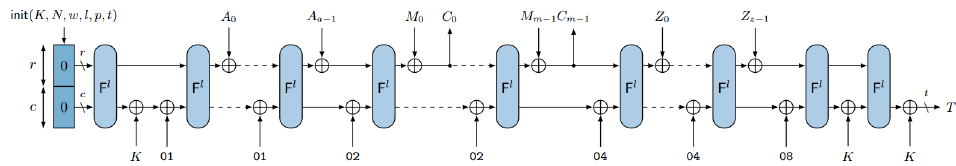
Figure 1: The layout of NORX construction (from [AJN16]). F l denotes an l -round permutation of